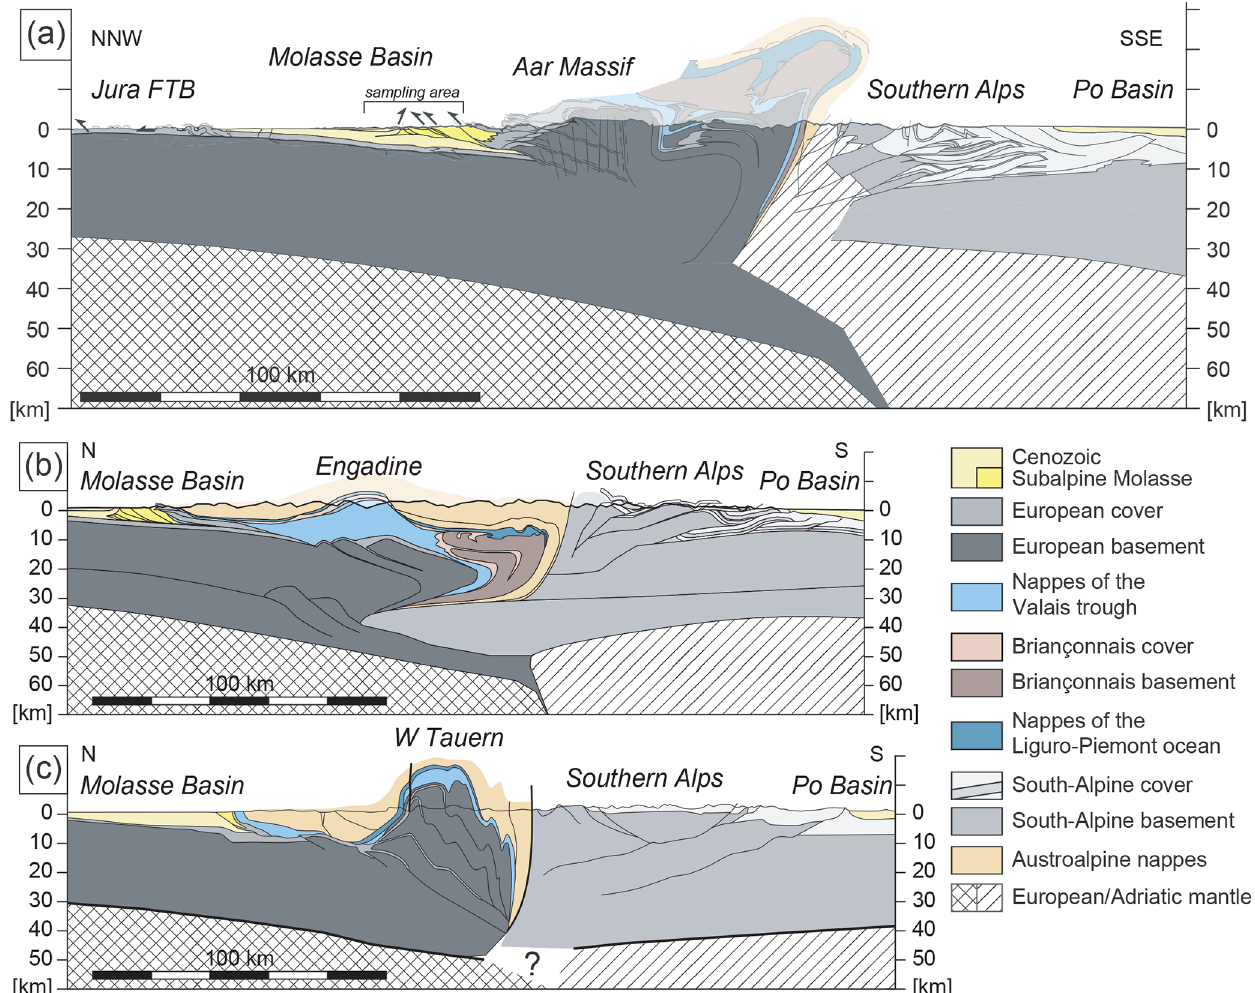
Figure 2. Cross sections through the Alps. (a) Jura – Plateau Molasse – Aar Massif (compiled from Buxtorf, 1916; Herwegh et al., 2017; Mock and Herwegh, 2017; Pfiffner, 2009; Rosenberg and Kissling, 2013). (b) Engadine Window (adapted from Rosenberg et al., 2015). (c) Western Tauern Window (adapted from Rosenberg et al.,